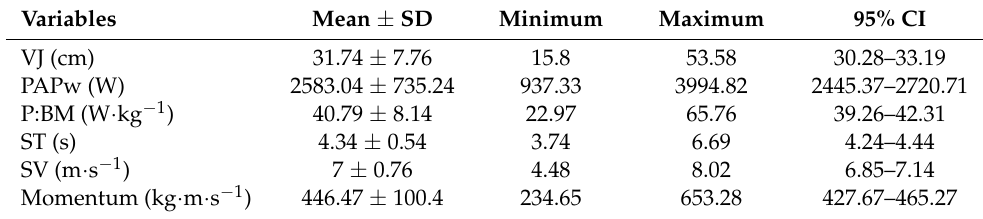
Table 2. Descriptive statistics (mean ± SD; 95% CI) for the jumping and sprinting variables in young adults (n =